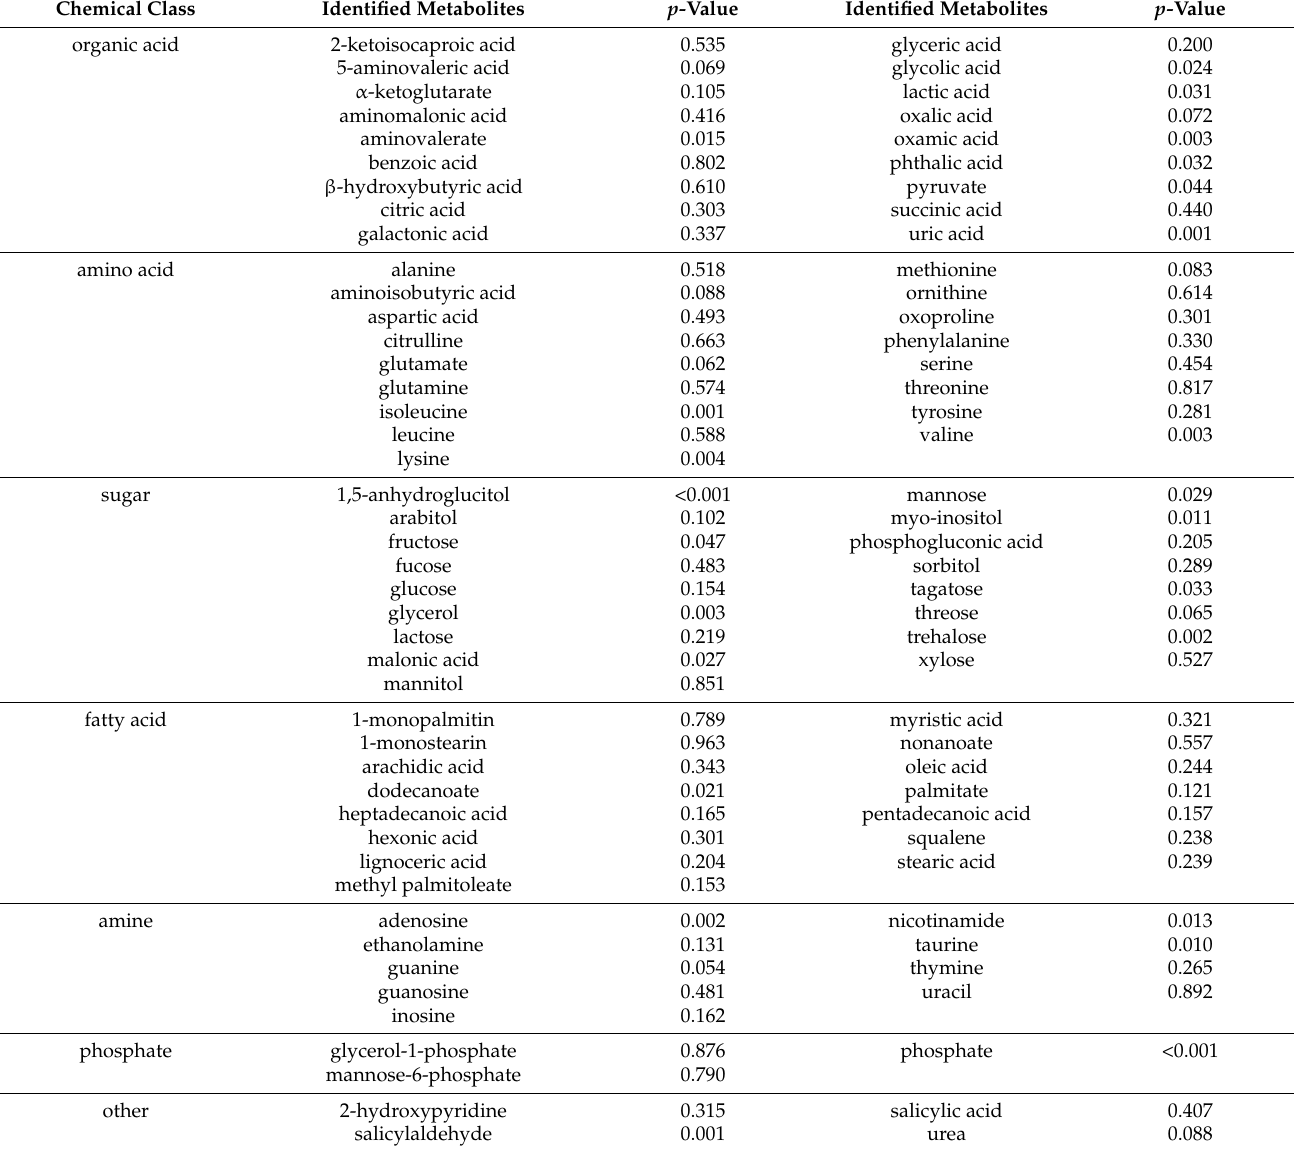
Table 2. List of identified metabolites by GC–TOF-MS and in-house